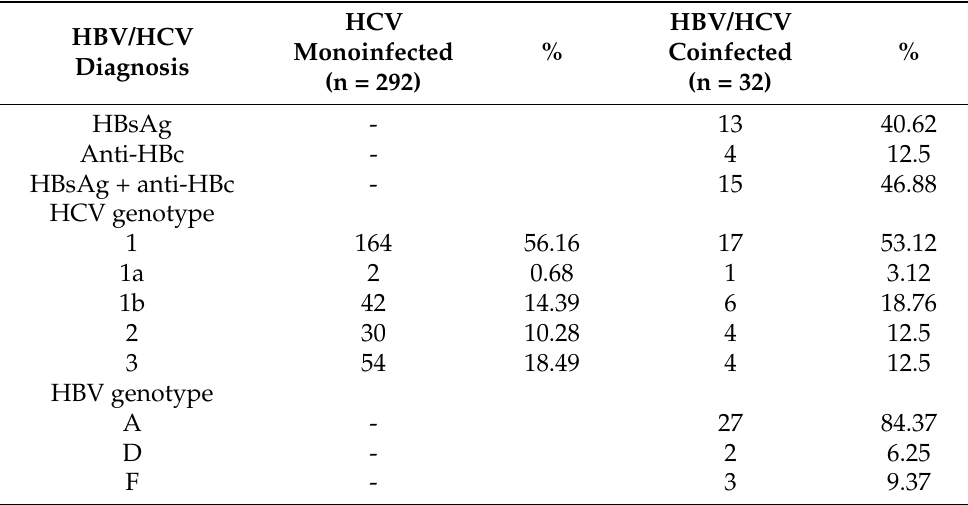
Table 1. Laboratory investigation of HCV and HBV in the study